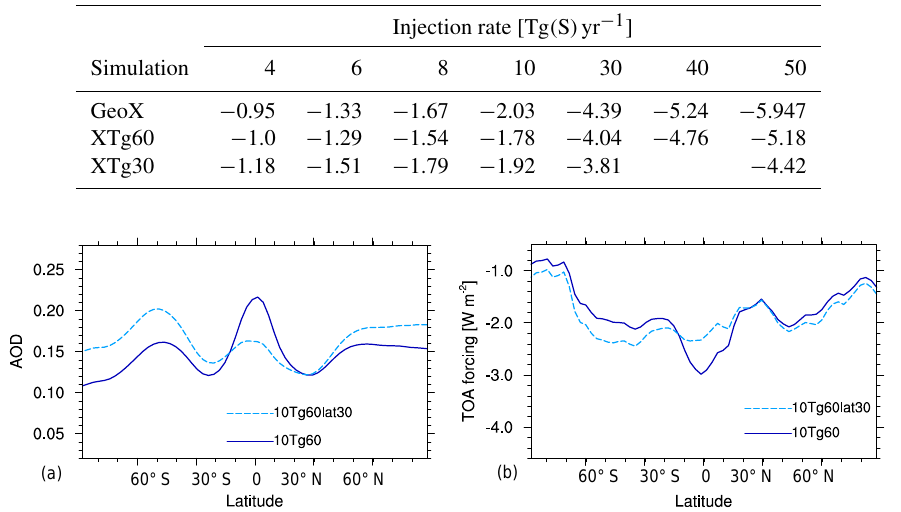
Figure 12. Aerosol optical depth at 550µm (a) and top of the atmosphere forcing (b) for an experiment with injections between 30 ◦ N and 30 ◦ S (10Tg60lat30) and